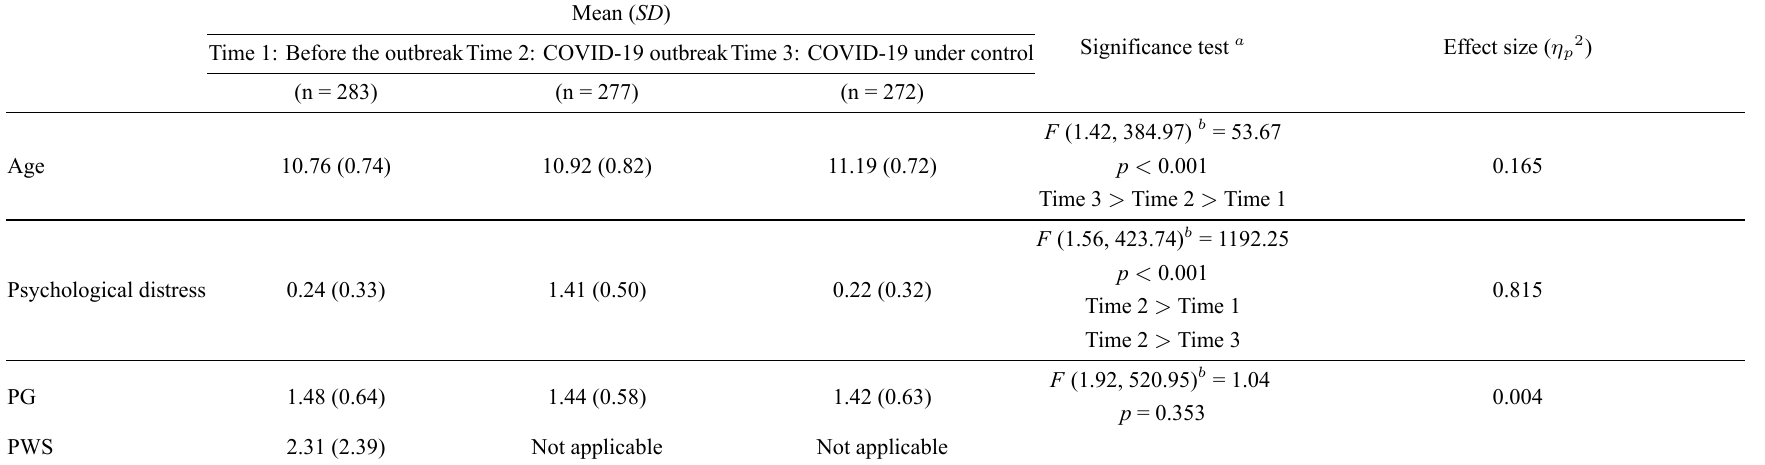
Table 1. Descriptive statistics and significance testing for age, psychological distress, problematic Internet gaming, and perceived weight stigma by